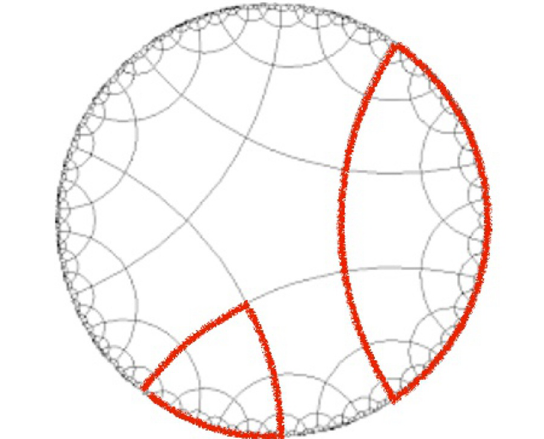
Figure 3 . The intersections of the two types of entanglement wedges described here with an apartment of the Bourdon building. Each geodesic should be seen as a portion of a tree-wall in the full